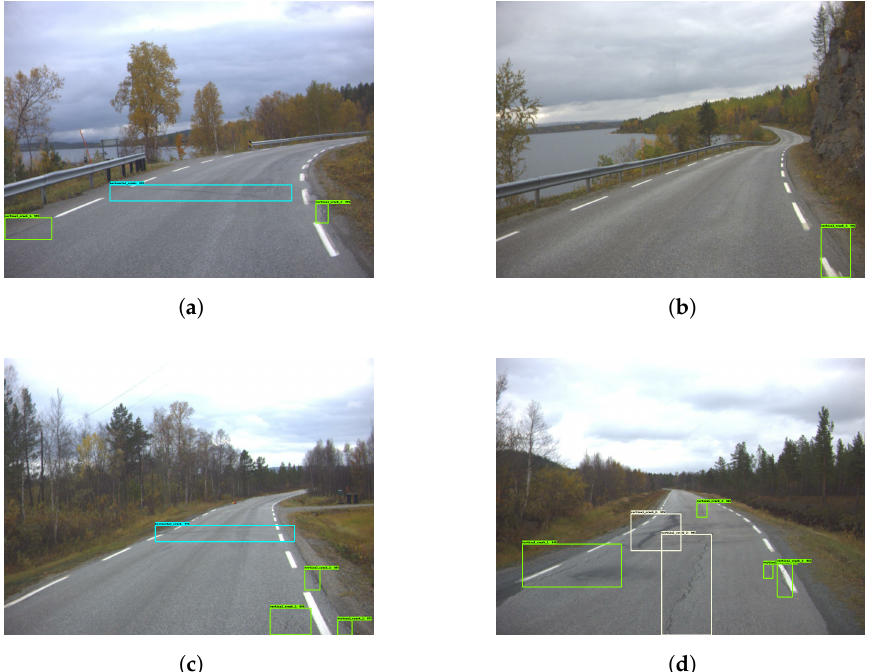
Figure 15. Good damage detection—Model 4. The green and yellow boxes represent the vertical cracks while cyan colored boxes are the horizontal cracks.